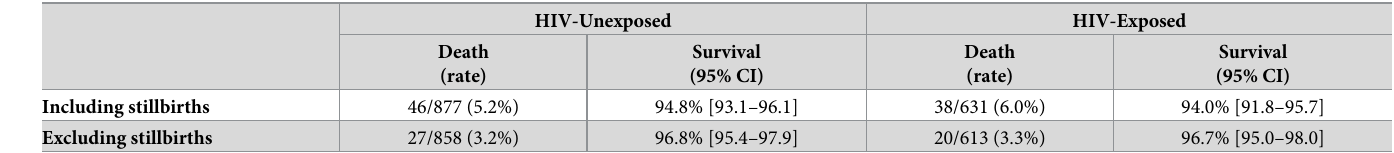
Table 3. Survival of HUI and HEI at six weeks of